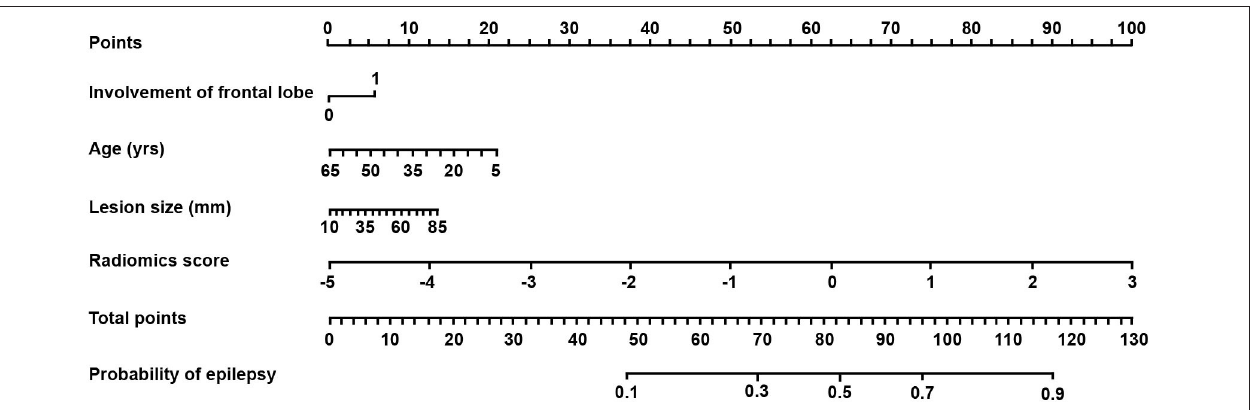
FIGURE 3 | The radiomics-clinical nomogram derived from the combined model. The nomogram was built based on patient age, lesion size, involvement of the frontal lobe, and radiomics score. With the nomogram, the probability of epilepsy for each patient could be calculated on the basis of a logistic regression formula using the total points.